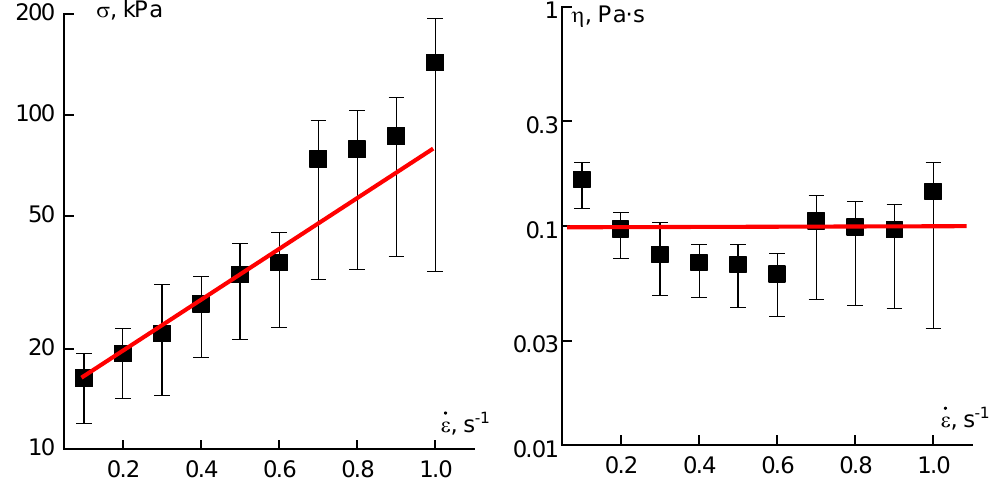
Figure 14. Dependences of the average stress ( left ) and calculated apparent elongation viscosity ( right ) on the average deformation rate in continuous spinning process of PAN solution.